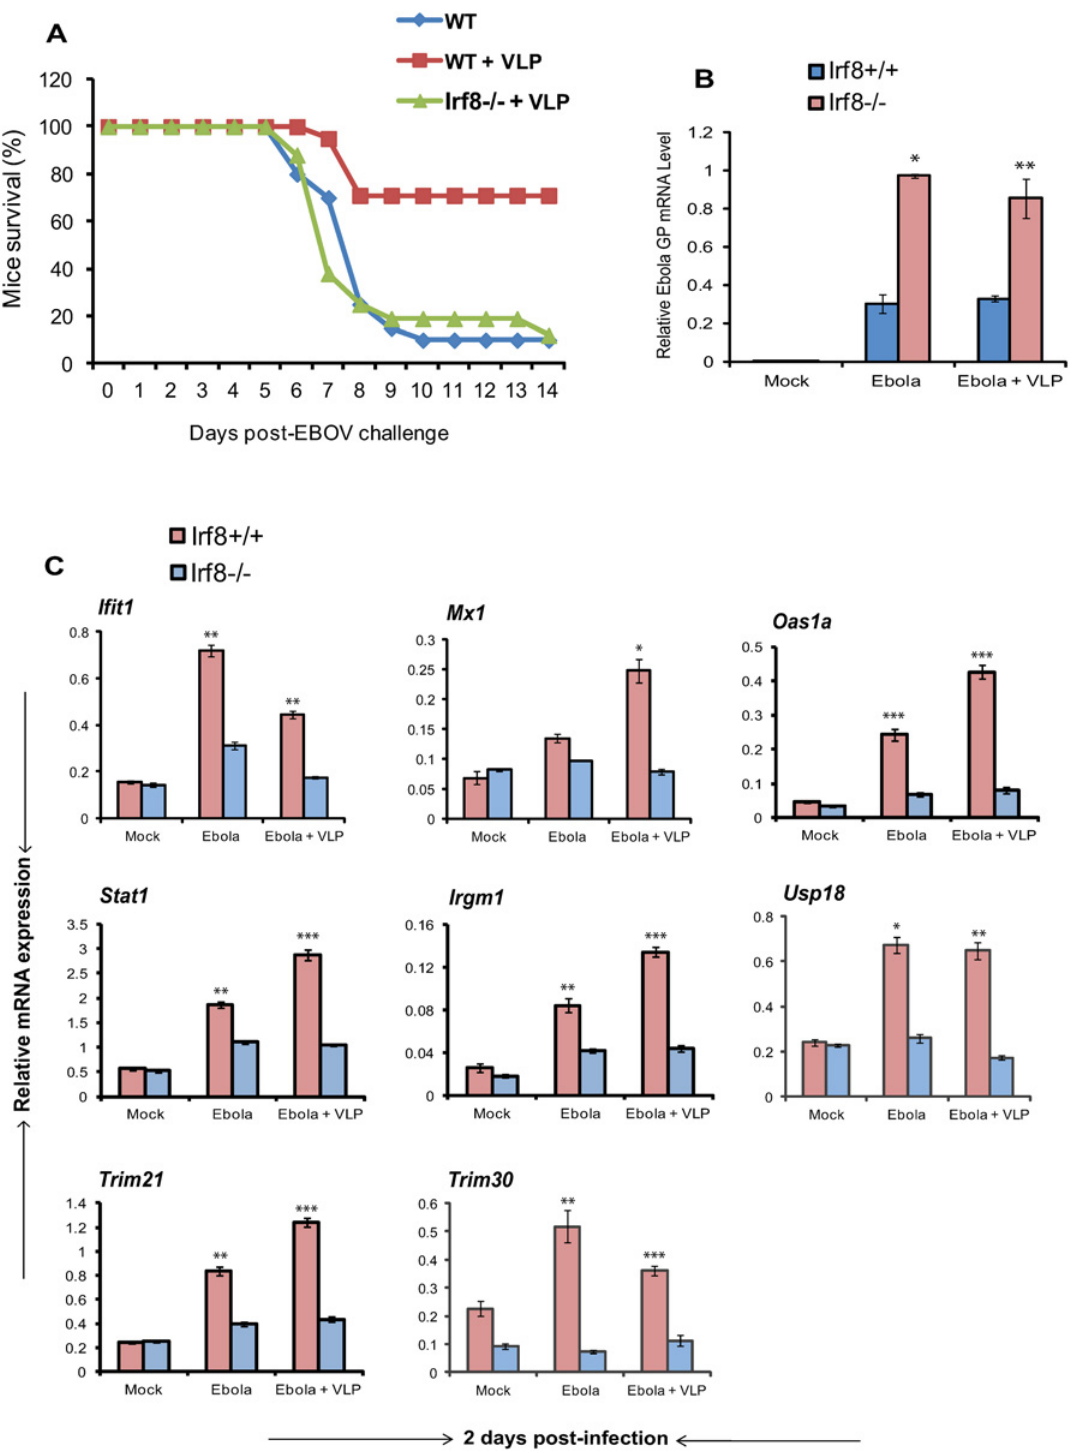
Fig 6. VLP post-exposure protection requires the transcription factor IRF8. (A) Irf8 +/+ (WT) and Irf8 -/- mice (n = 5/group) were infected with EBOV followed by VLP treatment as in Fig. 1A. Mortality is expressed as the percentage survival. (B) EBOV GP levels in liver were tested by qRT-PCR on day2. (C) Expression of indicated ISGs in Irf8 +/+ and Irf8 -/- liver was tested by qRT-PCR on day 2. Data represent the mean of duplicate samples ± SEM and a representative of three independent experiments. *** indicates P (cid:1) 0.001, ** P (cid:1) 0.01 and * P (cid:1) 0.05.